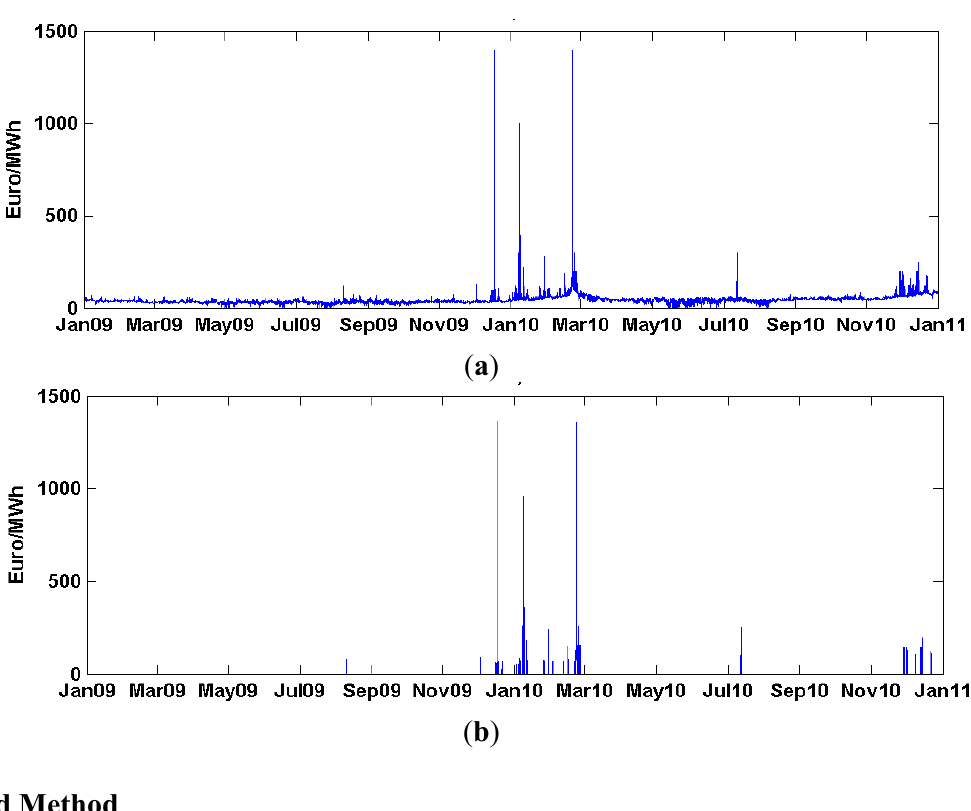
Figure 2. ( a ) Original price data of the Finnish day-ahead energy market in years 2009–2010; ( b ) Extracted price spikes.